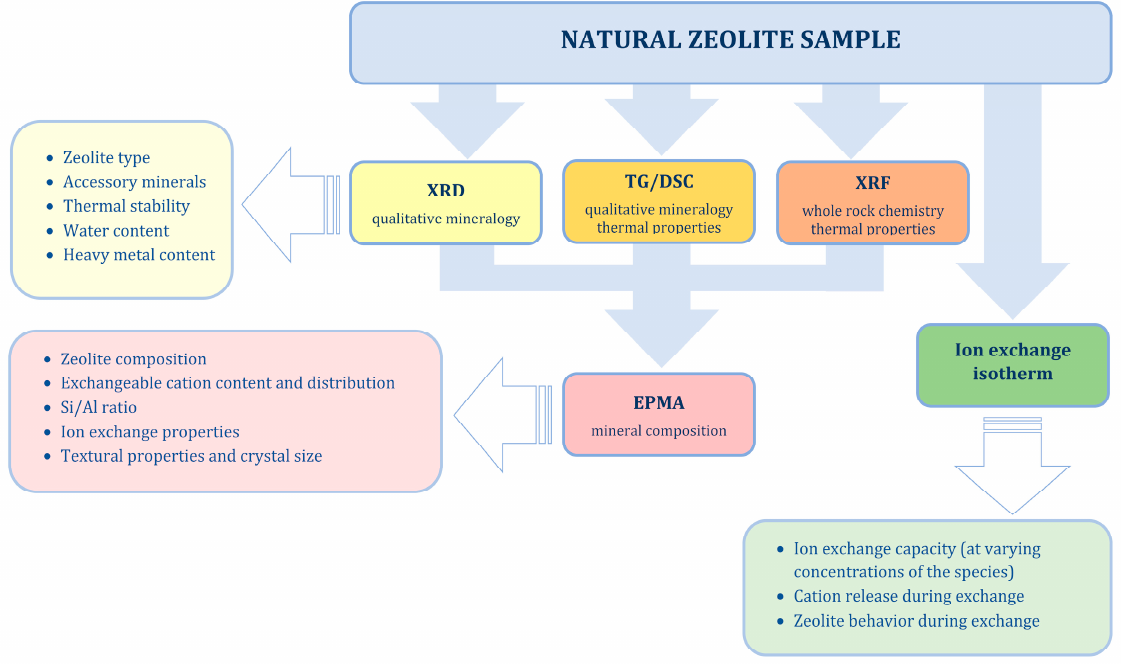
Figure 2. An example of an analytical protocol for determining the suitability of mineral raw materials for a given task. Adapted with permission from Stoker, K. et al. BHM ; published by Springer Nature, Cham, Switzerland AG, CC BY-NC-ND license (http://creativecommons.org/licenses/by-nc-nd/4.0/, accessed on 18 November 2022), 2017 [52].